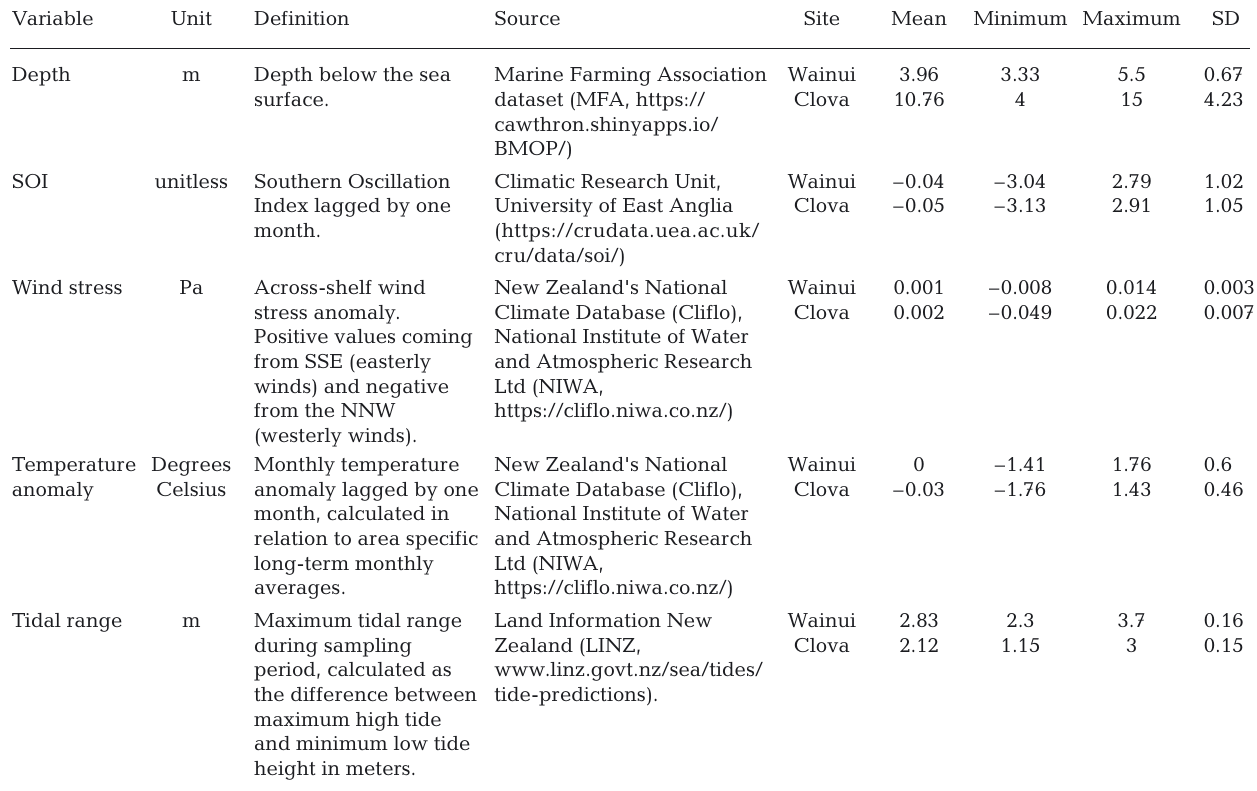
Table 1. Description, source and summary statistics of environmental data used in the boosted regression tree models of green-lipped mussel Perna canaliculus spat at 2 key industry sites: Wainui and Clova